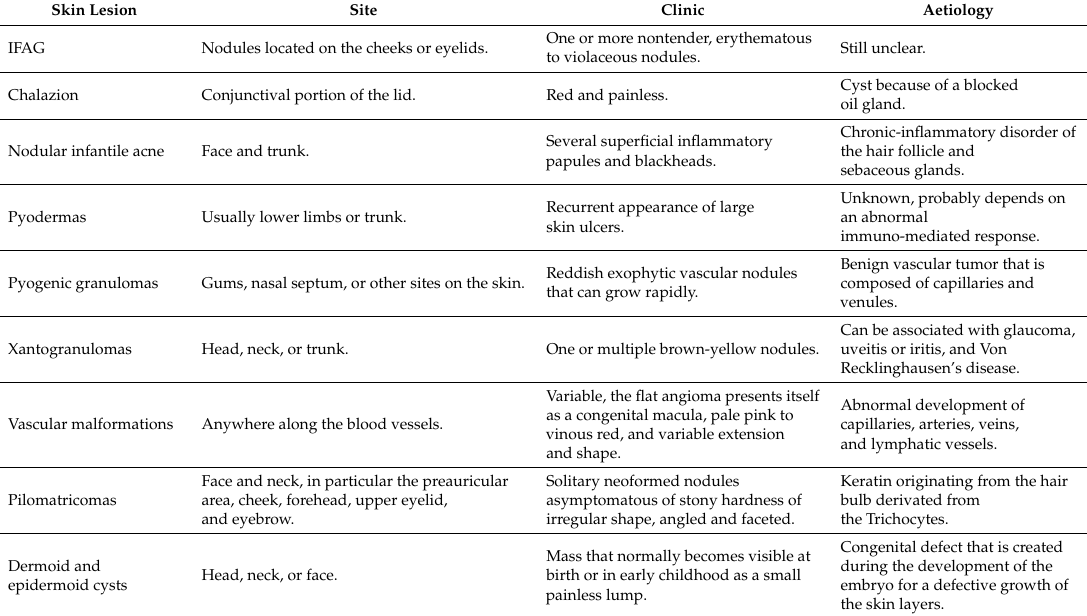
Table 1. Di ff erential diagnosis of idiopathic facial aseptic granuloma